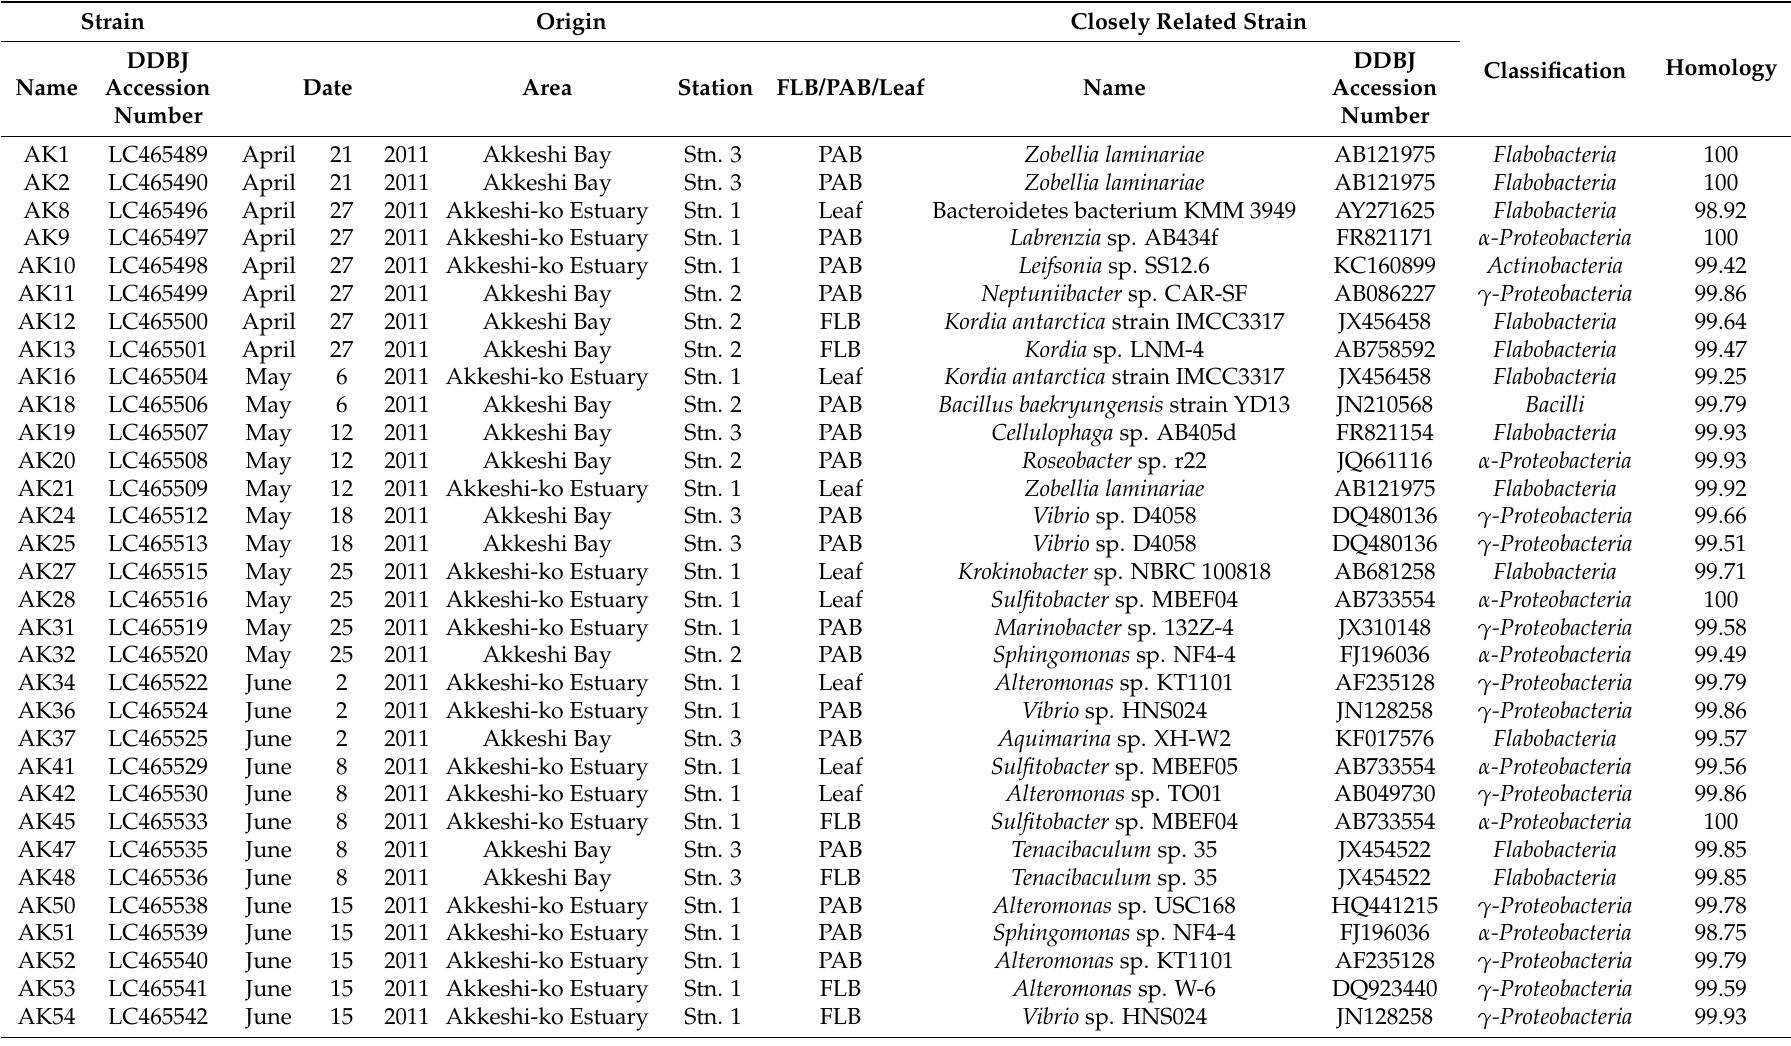
Table 1. Closest bacterial relatives of 16S rRNA gene sequences with growth inhibiting bacteria against Alexandrium catenella (Group I). Bacterial strains with homology more than 98.7% were described. FLB: Free-living bacteria (<3 µ m fractions), PAB: Particle-associated bacteria (>3 µ m